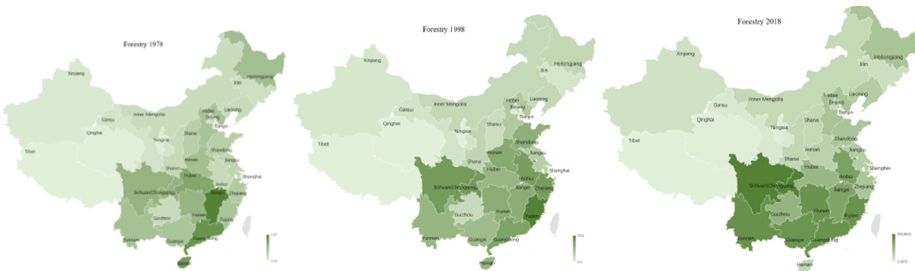
Figure 15. Geographic distribution of forestry GDP in 1978–2018.